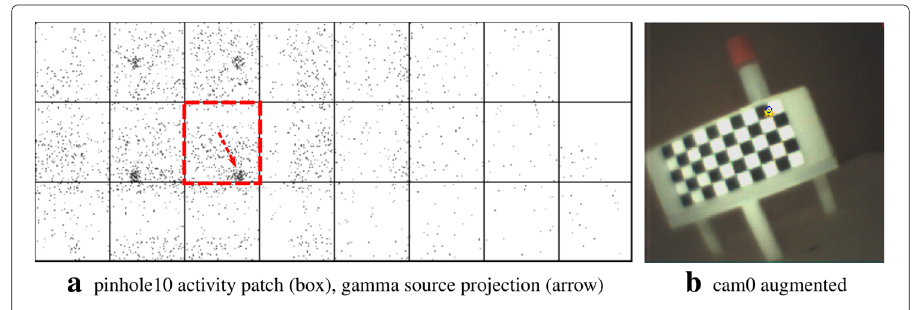
Fig. 10 Pair 1, known source distance 90 mm ( x 3 ), acquisition time 16 s. a Activity image. b The activity accumulation (orange) of the source near the exit pupil (blue circle) of the Cerrobend TM block is shown